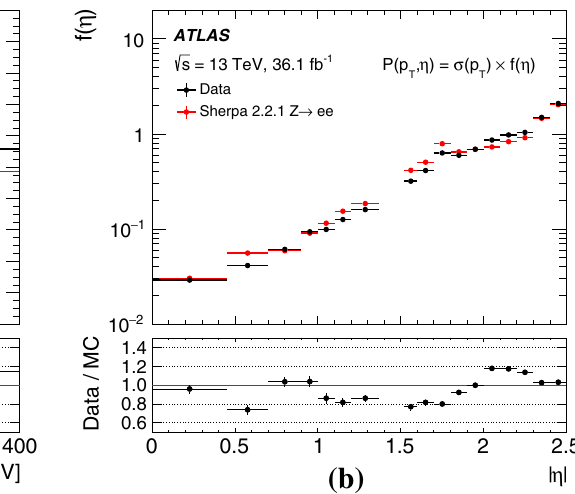
Error bars correspond to the statistical uncertainties estimated with the likelihood fit. Plot ( a ) shows the charge misidentification probability component as a function of p T and plot ( b ) shows the component as a function of | η |